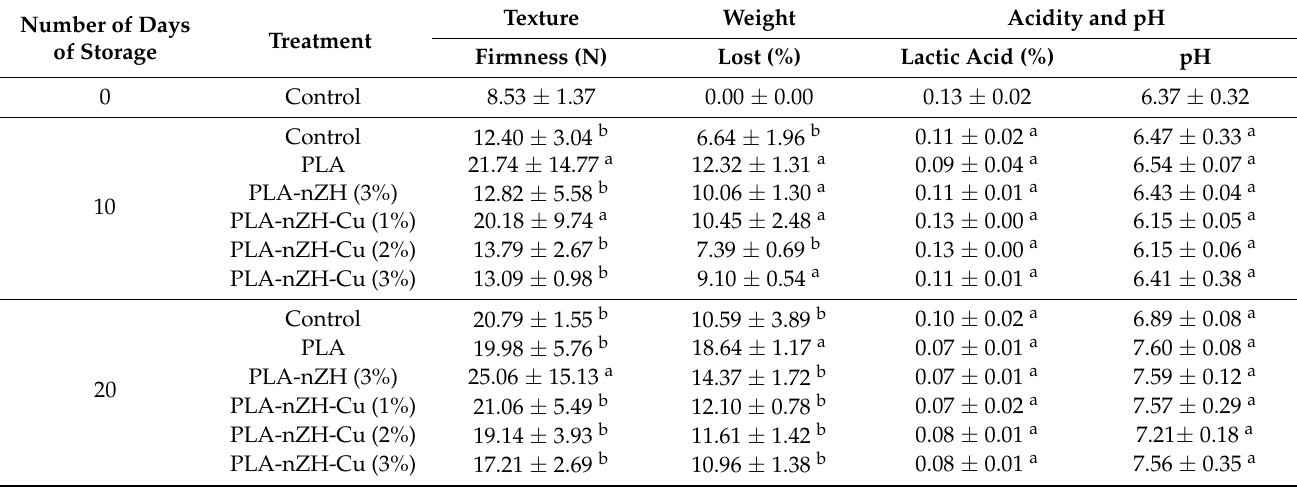
Table 4. Physicochemical quality (texture, weight, acidity, and pH) of chicken breast meat in contact with PLA-nZH-Cu nanocomposite films during storage at 4 ◦ C for 20